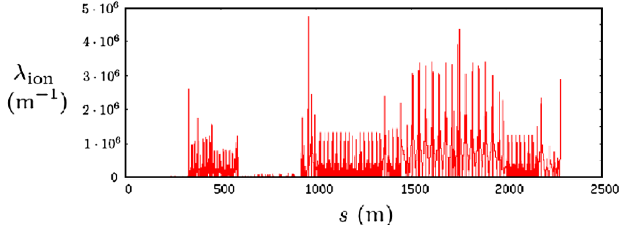
FIG. 10. (Color) Estimate of the linear ion density at the Cornell ERL for a round beam approximation and clearing electrodes at the minima of the linear